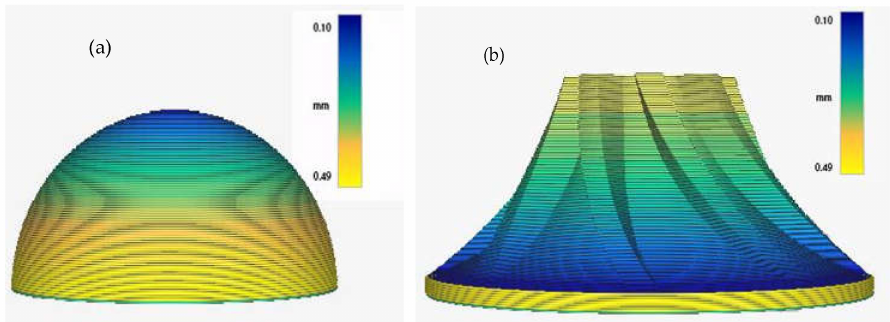
Figure 9. Optimal volumetric slices. ( a ) Hemispherical model. ( b ) Turbine blade model.